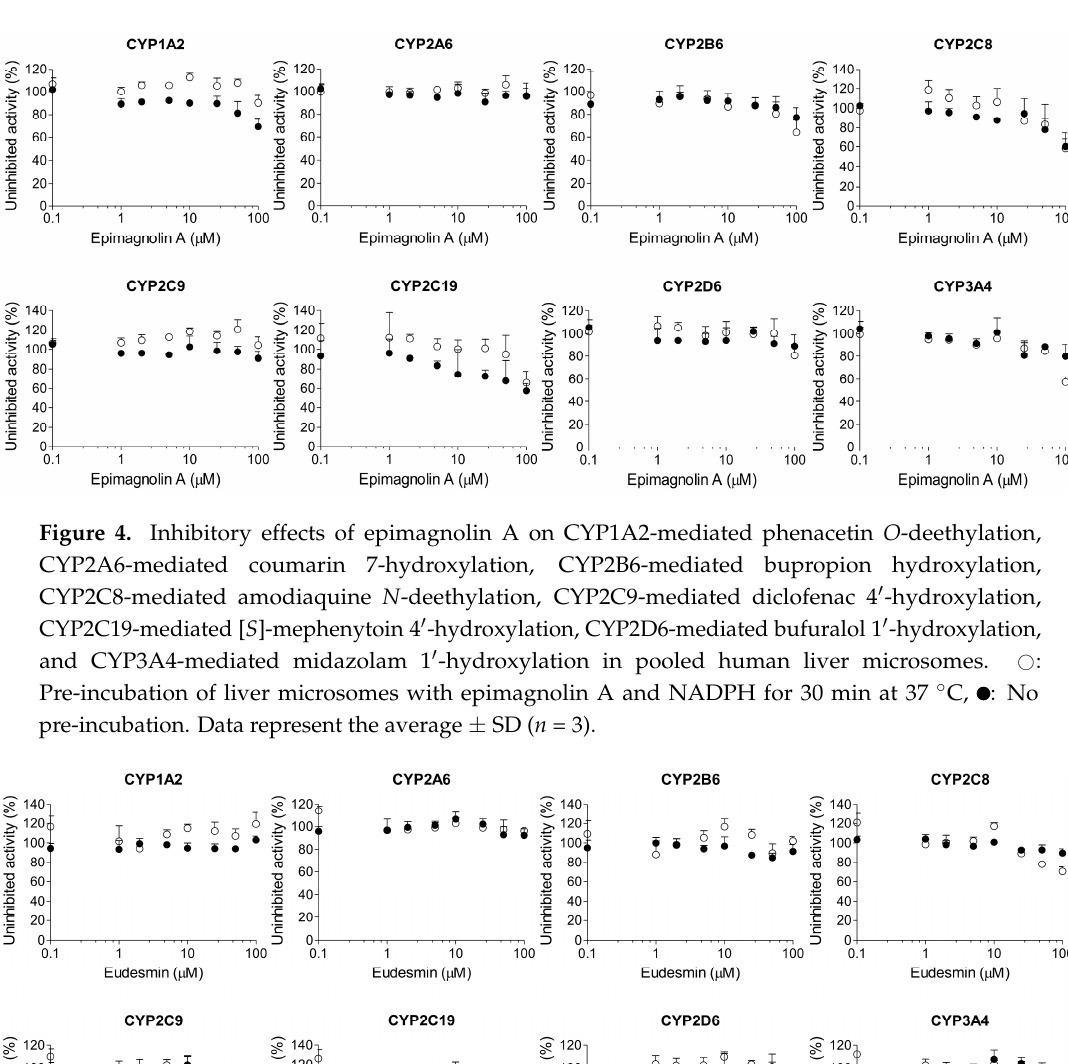
Figure 5. Inhibitory effects of eudesmin on CYP1A2-mediated phenacetin O -deethylation, CYP2A6-mediated coumarin 7-hydroxylation, CYP2B6-mediated bupropion hydroxylation, CYP2C8-mediated amodiaquine N -deethylation, CYP2C9-mediated diclofenac 4’-hydroxylation, CYP2C19-mediated [ S ]-mephenytoin 4’-hydroxylation, CYP2D6-mediated bufuralol 1’-hydroxylation, and CYP3A4-mediated midazolam 1’-hydroxylation in pooled human liver microsomes. : Pre-incubation of liver microsomes with eudesmin and NADPH for 30 min at 37 °C, : No pre-incubation. Data represent the average ± SD ( n = 3).